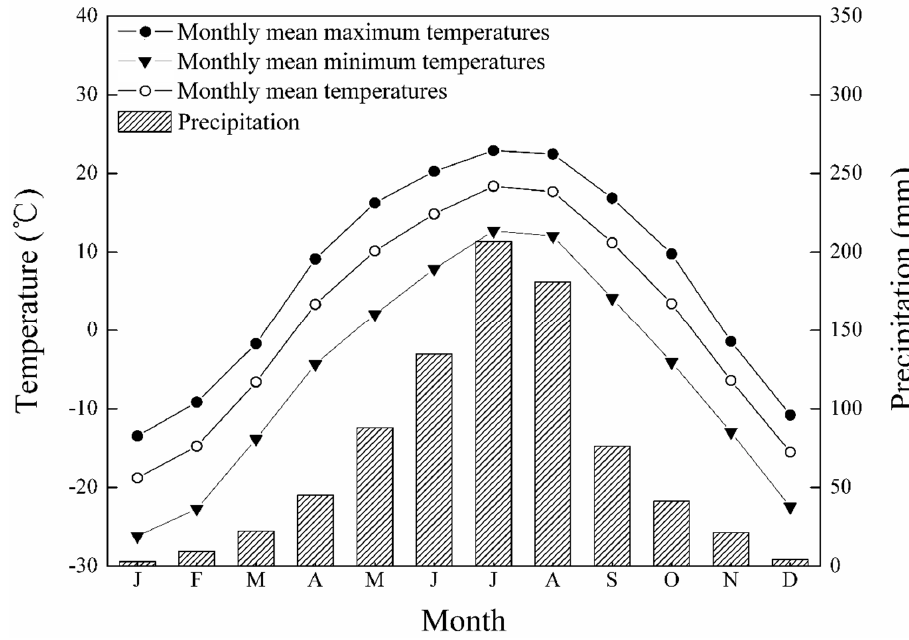
Figure 2. Total precipitation (in mm) and mean monthly temperature (in ◦ C) in Changbai Mountain (CBM) (AD